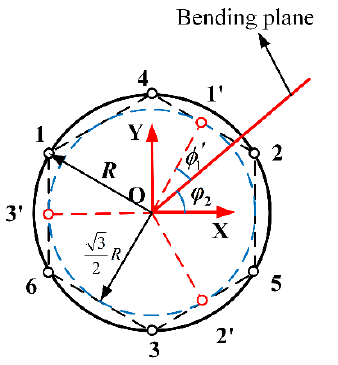
before and after simplification.